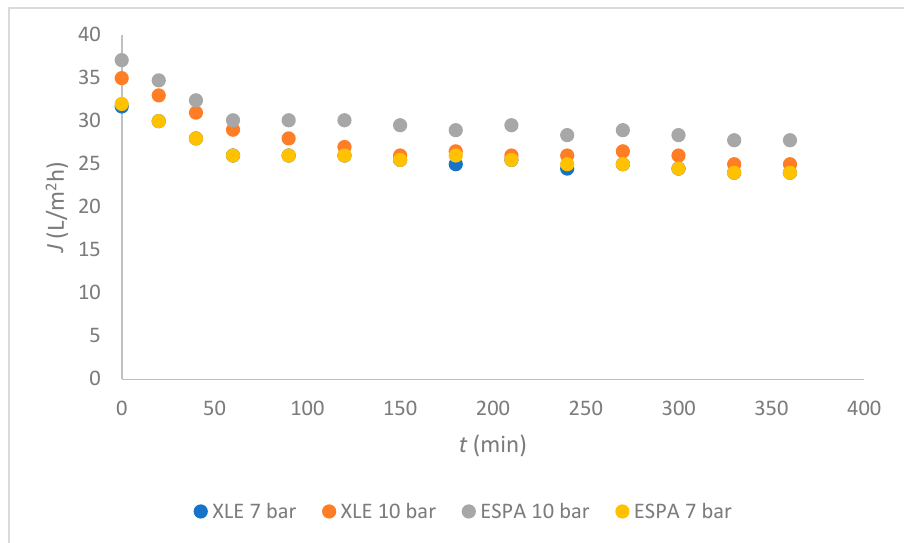
Figure 3. Flux dependent on time for both membranes.